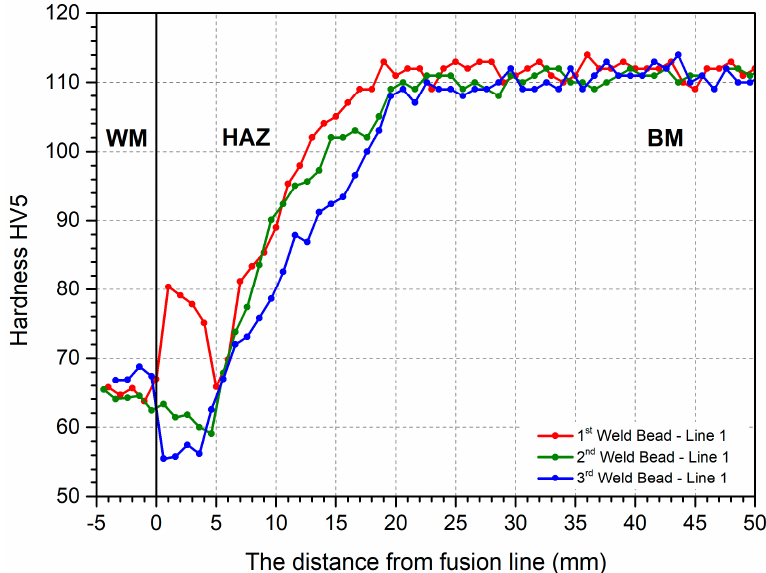
Figure 7. Measured hardness values in the weld metal, HAZ and base material for weld 1 (with preheating at 75 °C) in the zone of line 1 after application of one, two and three beads.